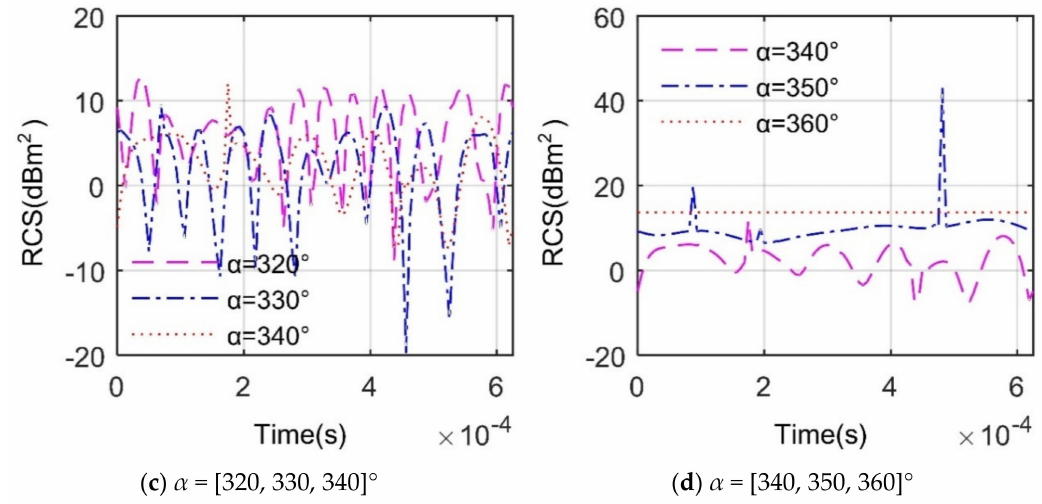
Figure 14. The dynamic RCS of m fan + m duct , N obs,fan = 1, α = (0~40 and 320~360) ◦ , and β = 0 ◦ . Figure 15 implicates that the RCS curve under the omnidirectional angle of the engine is obvious and cannot be ignored, while the RCS-time curves under di ff erent heading azimuths are very di ff erent. − 4 When t = 1.875 × 10 s, the peak value in the omnidirectional angle of the engine is 42.62 dBm 2 at α = 0 ◦ , while that of the engine at t = 3.75 × 10 − 4 s is 55.41 dBm 2 at α = 215.8 ◦ because the trailing edges and facets of the right blades of the low-pressure turbine is not easy to deflect the incident wave at this ◦ ◦ time. The RCS peaks at α = 90 and 270 at di ff erent times appear larger and stable, which is mainly ◦ ◦ due to the mediocre design of the huge engine duct. When α increases from 0 to 20 , the dynamic RCS curve of the engine becomes more fluctuating, but the peak and RCS averages decrease, because the strong scattering source at this time is mainly reflected in the duct of the engine, the azimuth angle increases, and the strong scattering source on the lip in the illumination area is transferred to the side of the duct. These results show that the omnidirectional RCS of the engine changes dynamically with time, and the di ff erence of dynamic electromagnetic scattering at di ff erent azimuths is obvious.